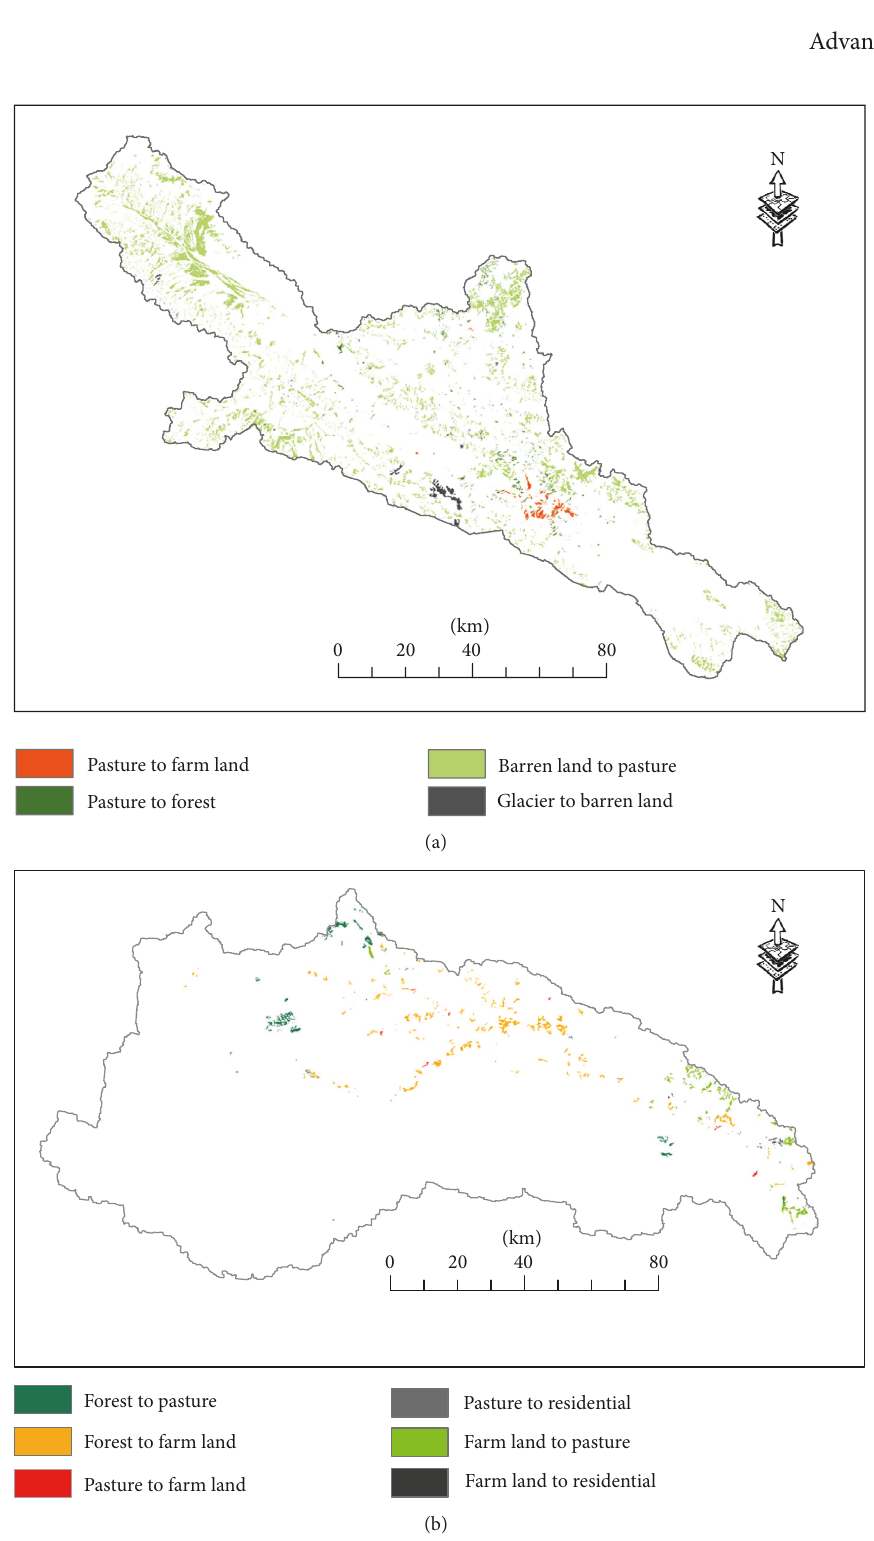
Figure 6: Spatial distribution of dominated land use conversion in YLC (a) and MXC